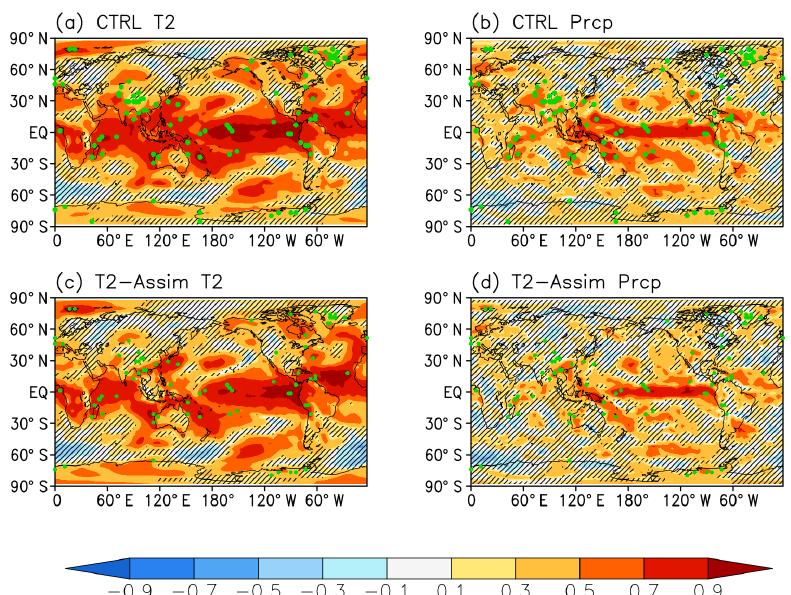
Figure 7. Temporal correlations between the analysis and the truth for (a, c) temperature and (b, d) precipitation, for (a, b) CTRL and (b, d) T2-Assim. The green dots represent the location of the proxy sampling site. The hatched areas mean that the correlation is not statistically significant ( p > 0 . 05).